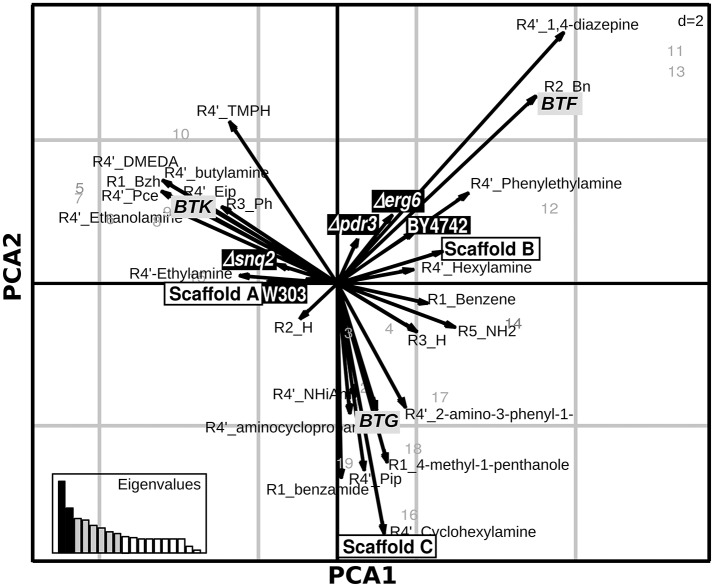
Relationship among chemical features of selected compounds and their activity. Duality diagram for the first two principal components obtained by analyzing correspondence between the ΔODst %and the chemical features of the molecules selected at the first-level. The cases for analysis were the molecules selected in the first level assay as able to induce a W303 ODst decrease higher than the 20% with respect to the ODst of the untreated culture. The variables are both the ΔODst % induced by the molecules on the tested strains and the molecule chemical features (substituent types, scaffold types); black-boxes labels: effects on the tested strains, white-boxes labels: molecules classification as shown in Figure 1A, gray-boxes labels: molecules classification as shown in Figure 1B. PCA1, First Principal Component; PCA2, Second Principal Component.